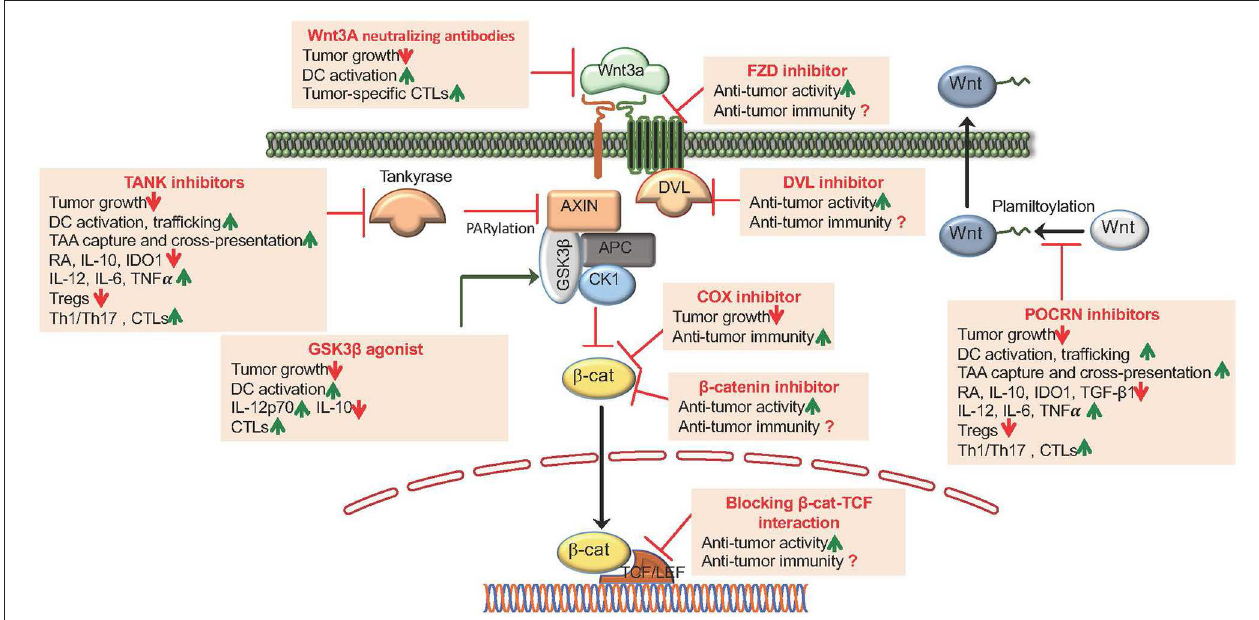
FIGURE 3 | Pharmacological targeting of Wnt/ β -catenin signaling augments anti-tumor activity and anti-tumor immune responses. The canonical Wnt signaling pathways can be targeted at four different levels: (1) Blocking Wnt ligand interaction with Fzd receptors by utilizing Wnt ligand antagonists that includes mAbs generated against the Wnts and Fzds and DKK1; (2) Blocking Fzd-LRP5/6 signaling by utilizing POCRN or DVL inhibitors; (3) Promoting β -catenin degradation by utilizing TNKS inhibitors, β -catenin-destruction complex activators that targets the Ser/Thr kinases CK1 α or GSK3 β and COX inhibitors and (4) Antagonizing β -catenin interaction with TCFs utilizing several small molecule modulators and synthetic